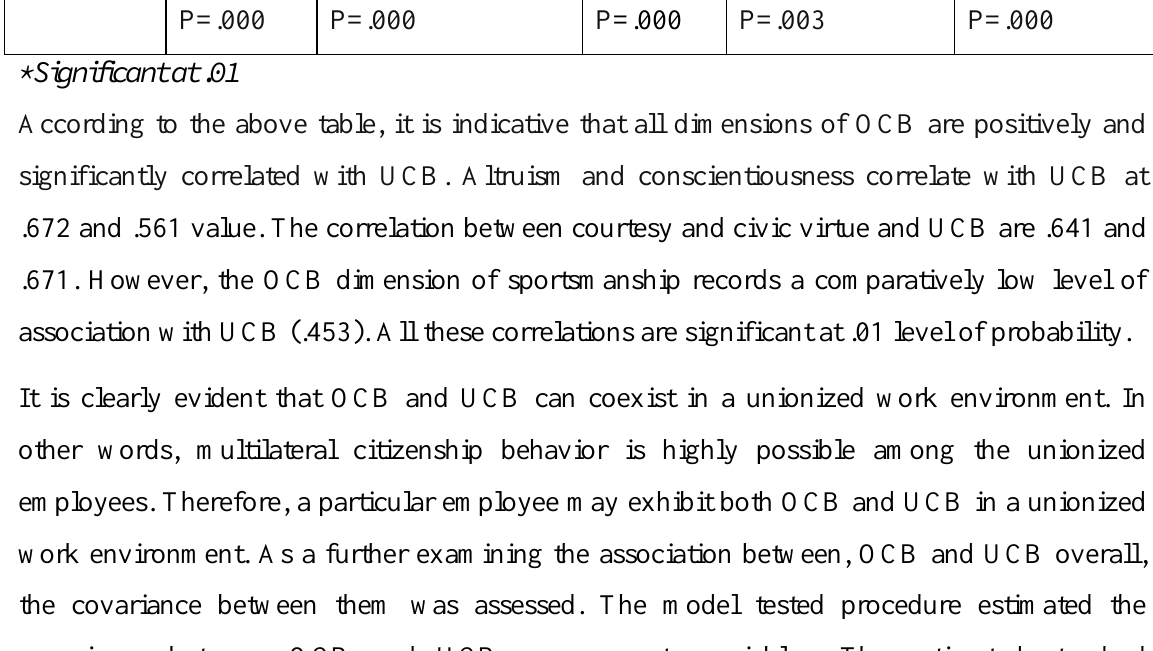
Table 1: Correlation between Dimensions of OCB and UCB Altruism Conscientiousness Courtesy Sportsmanship Civic Virtue .561 UCB .672 P=.000 P=.000